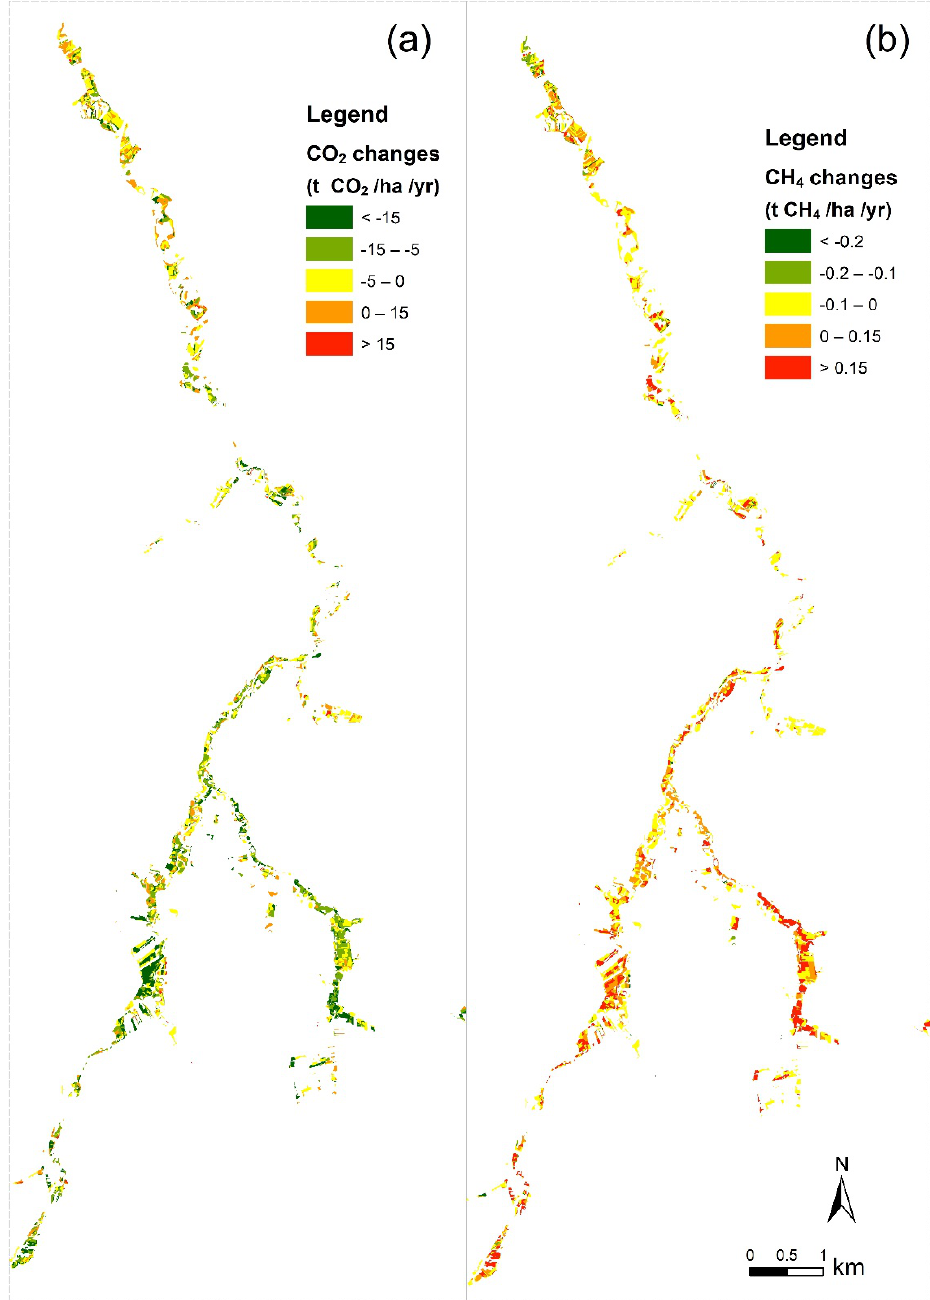
Figure 2. GHG fluxes changes of (a) CO 2 and (b) CH 4 after rewetting. Green and yellow colours show reduction and reddish colours show increase on corresponding GHG